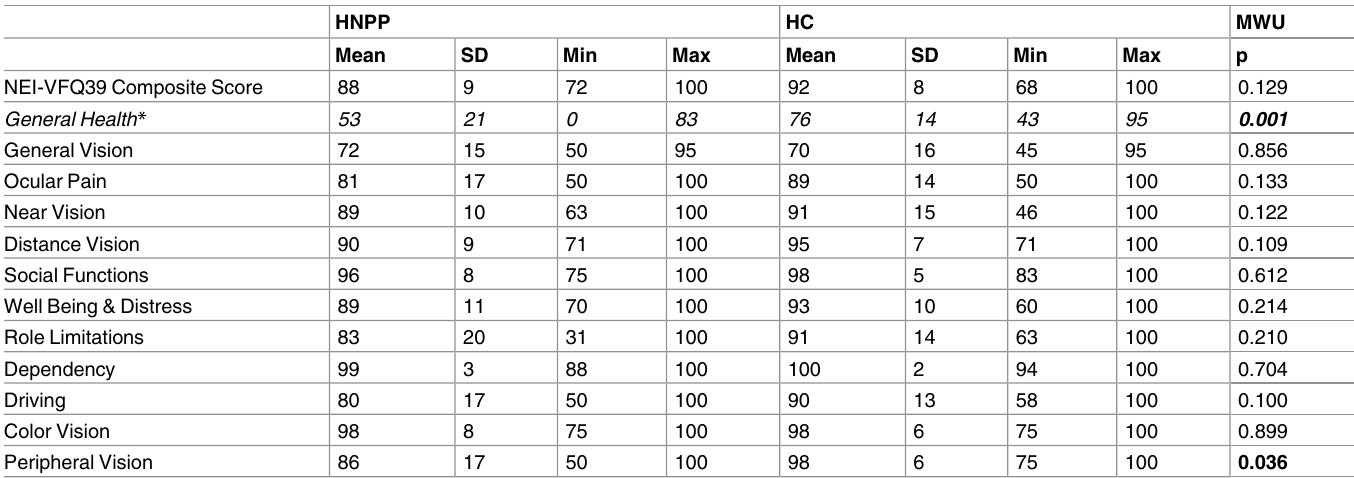
Table 1. Vision-related quality of